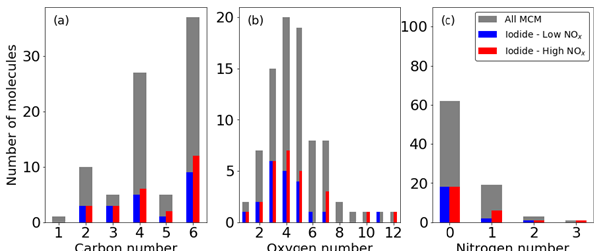
Figure 6. Fraction of ions observed from the MCM in the high- and low-NO x experiments expressed as the number of molecules con- taining atom numbers for (a) carbon, (b) oxygen, and (c)